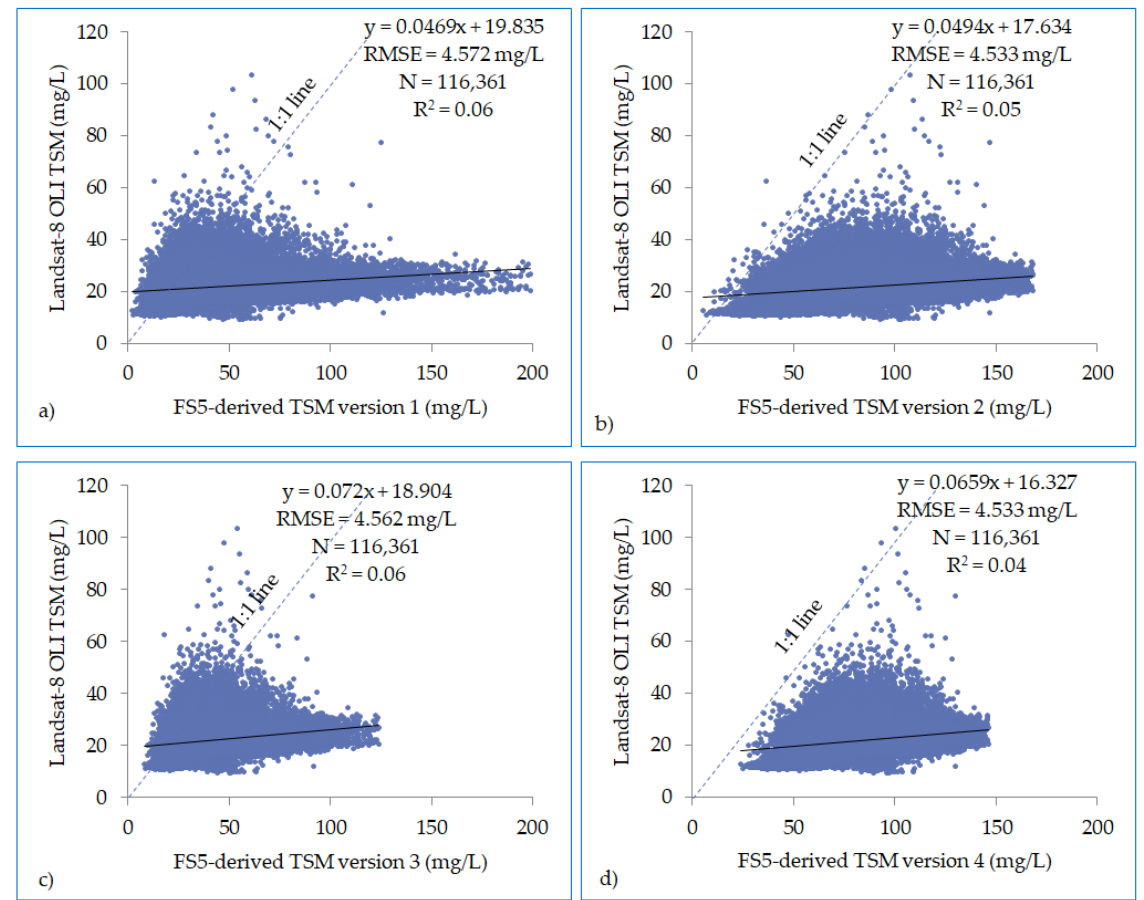
Figure 7. Comparison of the accuracy of FS5-derived TSM and Landsat-8 OLI-derived TSM; ( a ) FS5-derived TSM version 1; ( b ) FS5-derived TSM version 2; ( c ) FS5-derived TSM version 3; ( d ) FS5-derived TSM version 4.